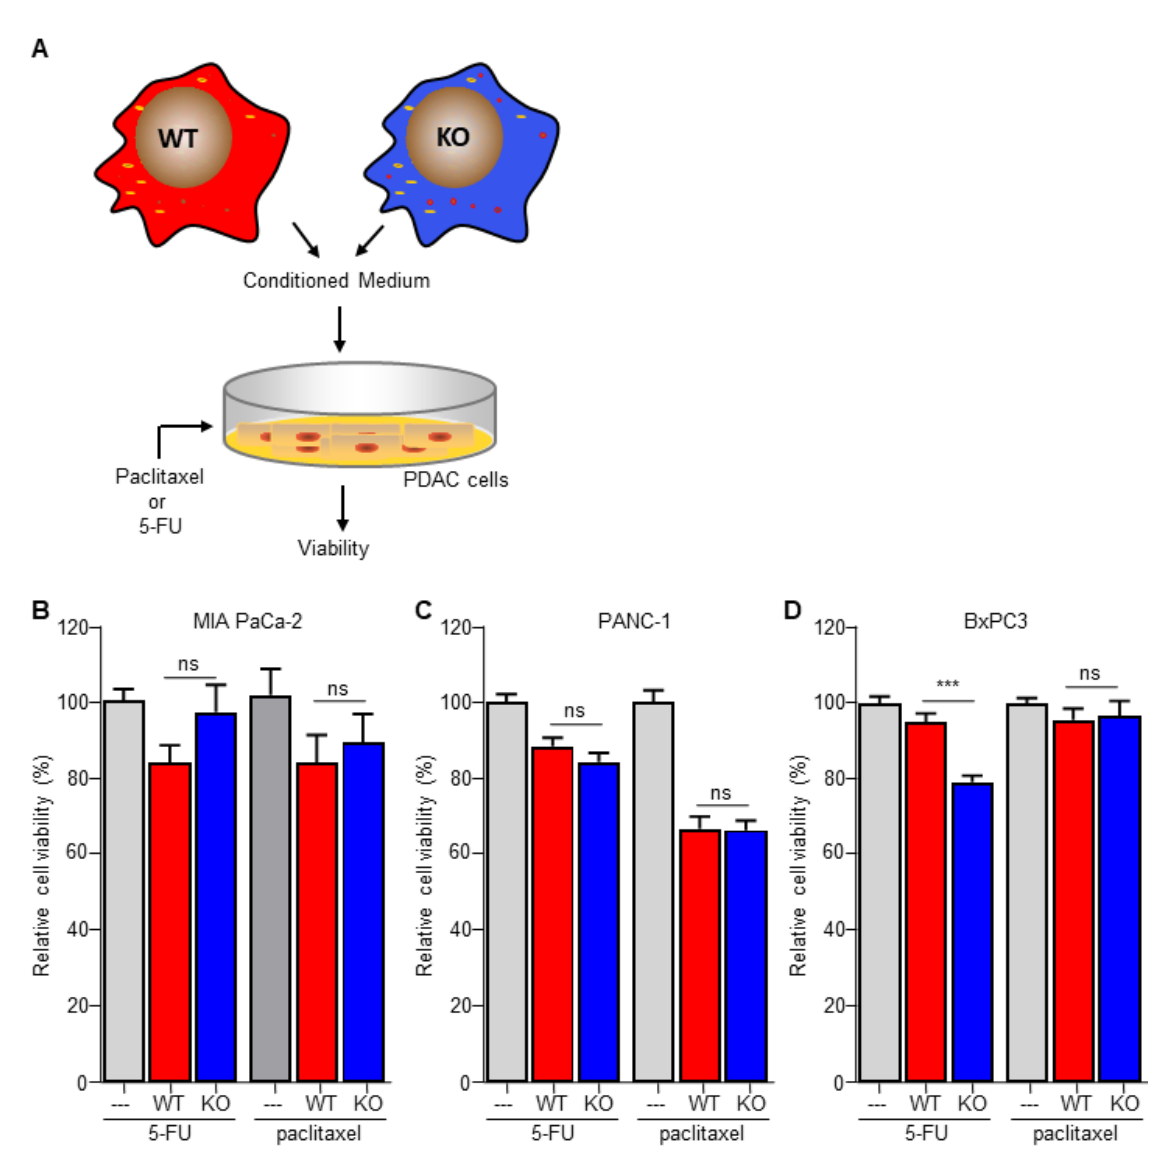
Figure 4. Macrophage C/EBP δ selectively induces resistance to gemcitabine. ( A ) Schematic overview of the experimental set up. ( B – D ) Viability of Mia PaCa-2 ( B ), BxPc3 ( C ) and PANC-1 ( D ) pancreatic cancer cells in control medium (—), conditioned medium obtained from wild type macrophages (WT) and conditioned medium obtained from C/EBP δ -deficient macrophages (KO) in the presence of 5-FU or paclitaxel. Shown is the mean ± SEM of an experiment performed in sixplo. *** p < 0.0001; ns: not significant .